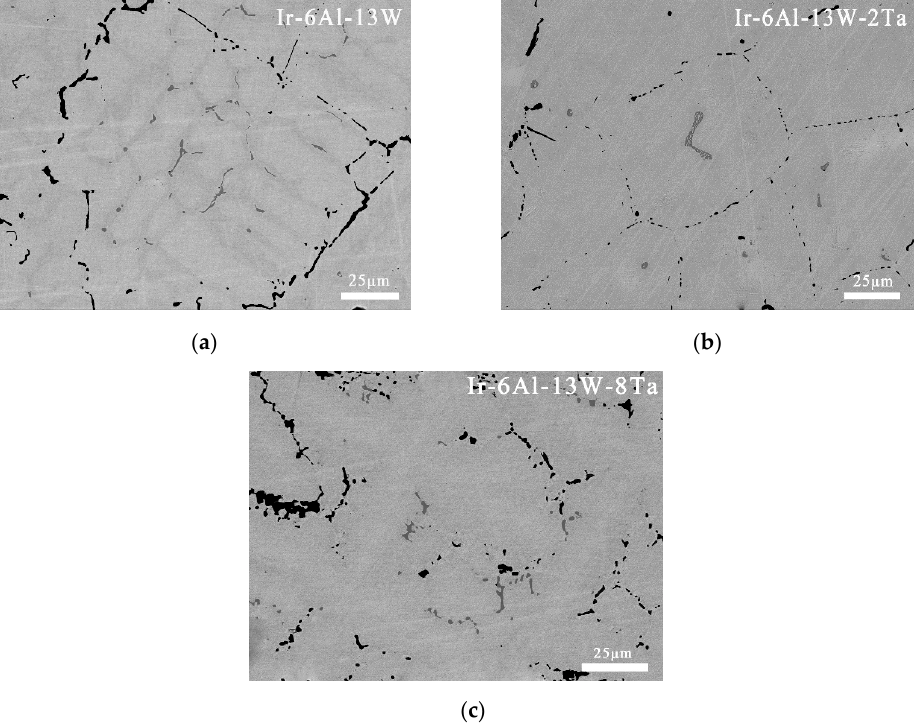
Figure 4. BSE images of the alloys homogenized at 1900 °C for 1.5 h: ( a ) Ir–6Al–13W; ( b ) Ir–6Al–13W– Figure4. BSEimagesofthe alloys homogenizedat1900 ◦ Cfor1.5h: ( a )Ir–6Al–13W; ( b )Ir–6Al–13W–2Ta; 2Ta; and ( c ) Ir–6Al–13W–8Ta. and ( c )